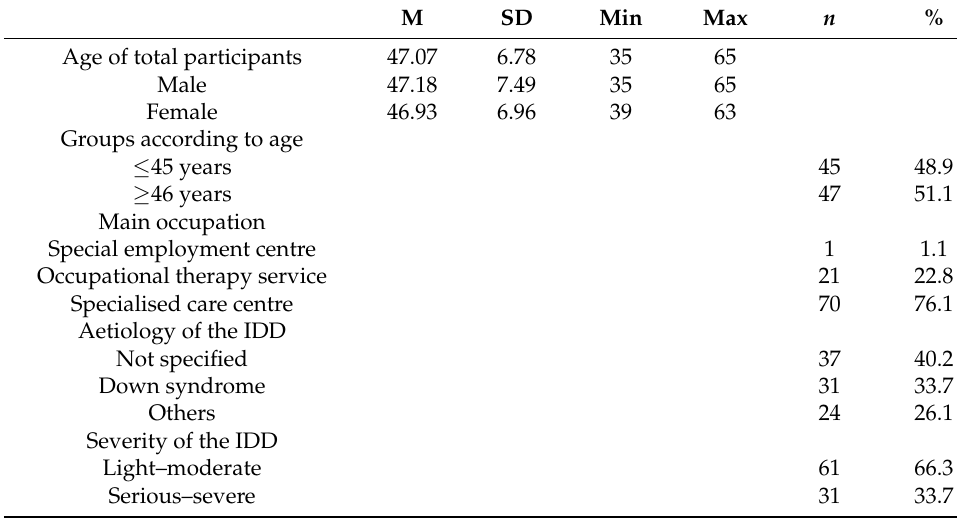
Table 1. Sociodemographic characteristics of the